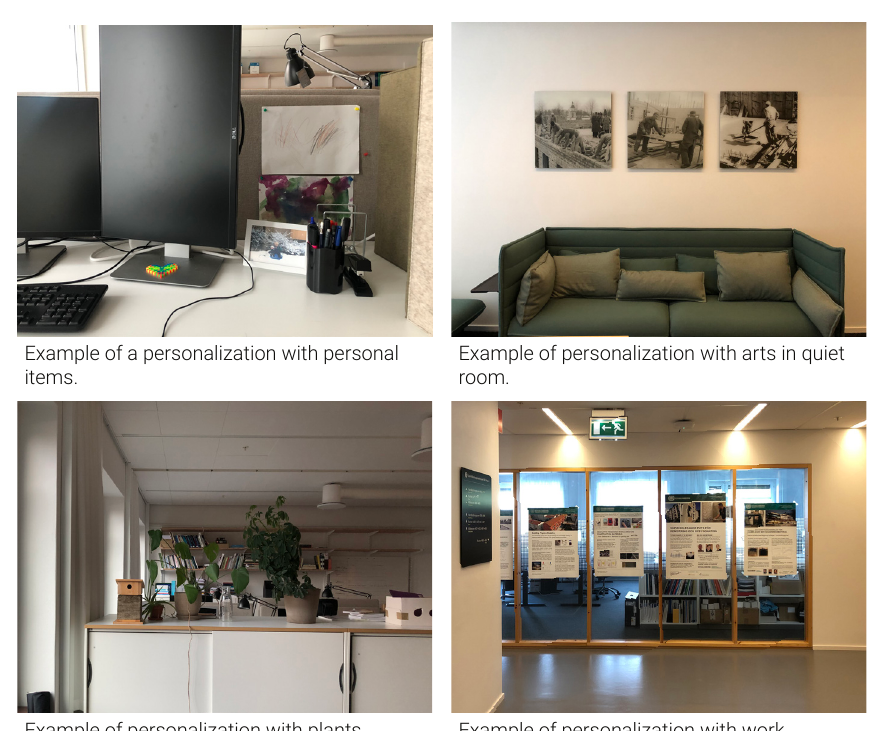
Figure 14. Examples of